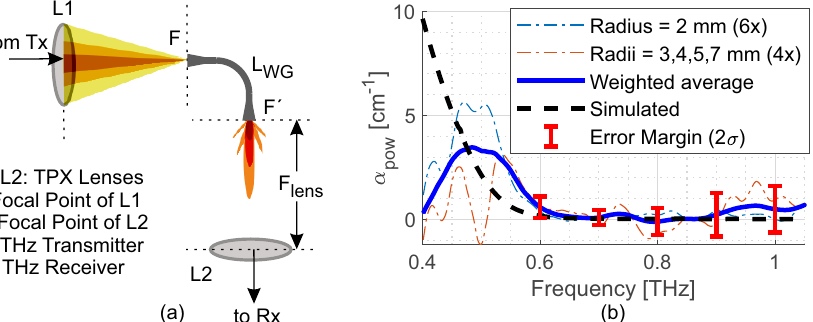
Figure 2. ( a ) shows the setup used for measuring the transmission through the waveguide structures. The Rx module is rotated by 90 ◦ in order to prevent line-of-sight coupling from Tx. All waveguide structures therefore include a 90 ◦ bend. ( b ) Measured power attenuation coefficient for the straight waveguide sections and its comparison with the simulated loss. α pow is averaged over 25